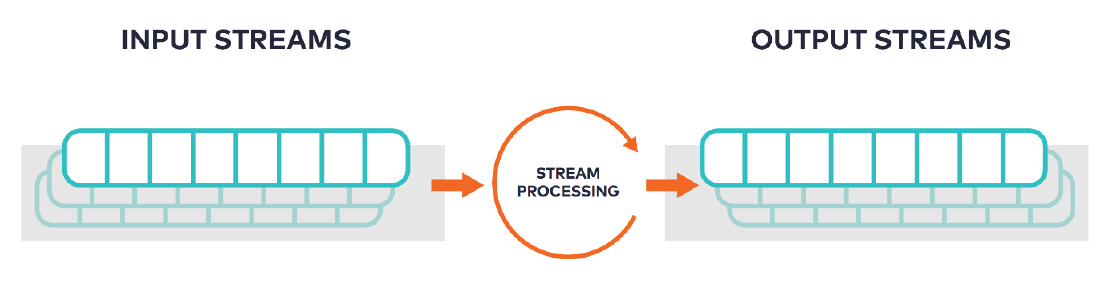
Figure 3. Infinite flow of streams